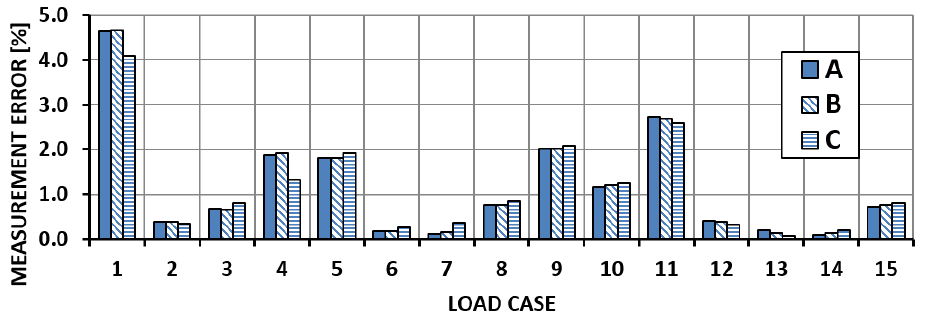
Figure 9. Bending moment measurement error—Section II.